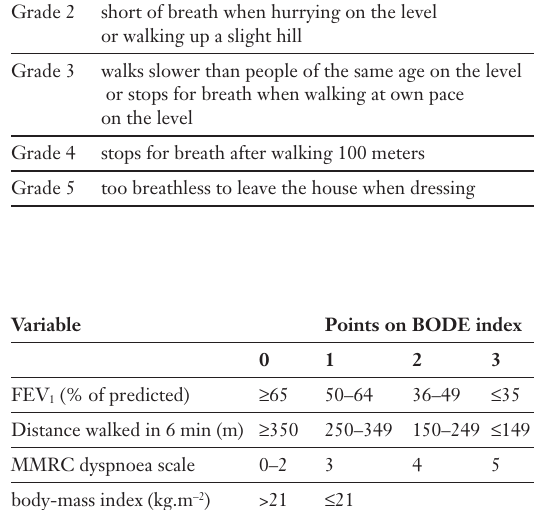
Modified MRC dyspnoea scale.